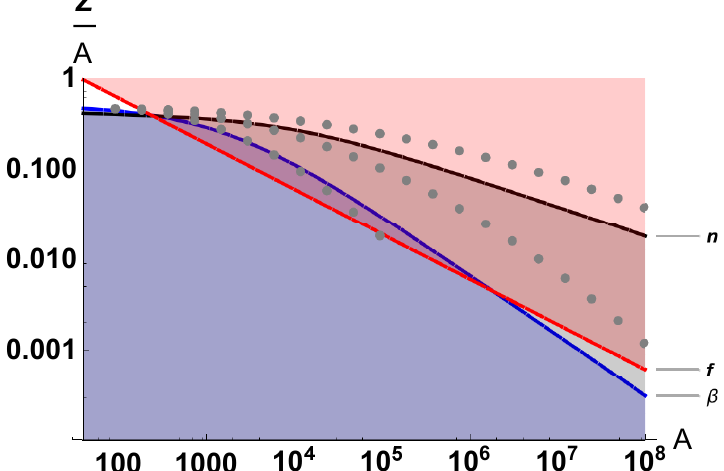
Figure 11. Evolution “jumps” in fission cascades (from right to left) leading to 92 Mo (final left gray dot). Each “ancestor” simply splits in two, and parametrized adjustment for the “loss” of neutrons due to n - and β -emissions is included at each fission event. Placement of critical lines: β -line (blue), n -line (black), and fission-limit f -line (red). In the shaded red zone, fission takes place. In the shaded gray zone, n -emission takes place. In the shaded purple zone, β -emission takes place. Jump-paths are discussed in the main